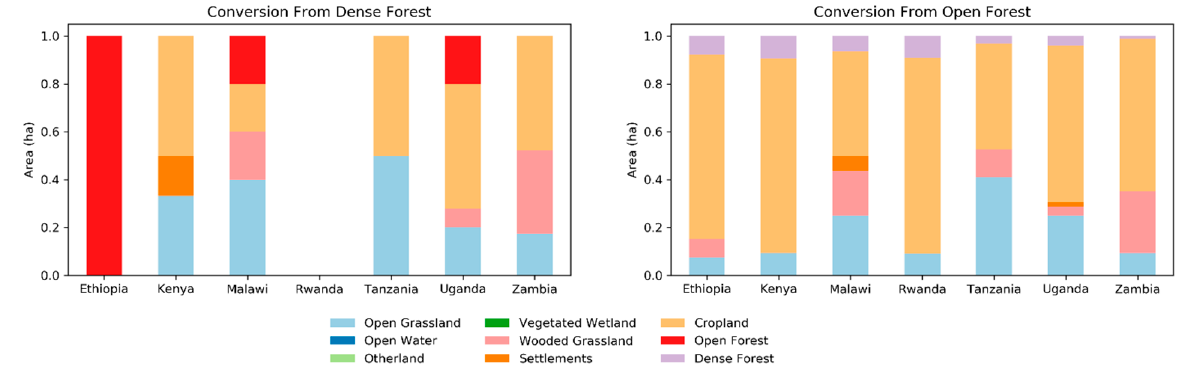
Figure 9. The proportion of land cover area after deforestation of Dense Forest ( left ) and Open Forest ( right ).